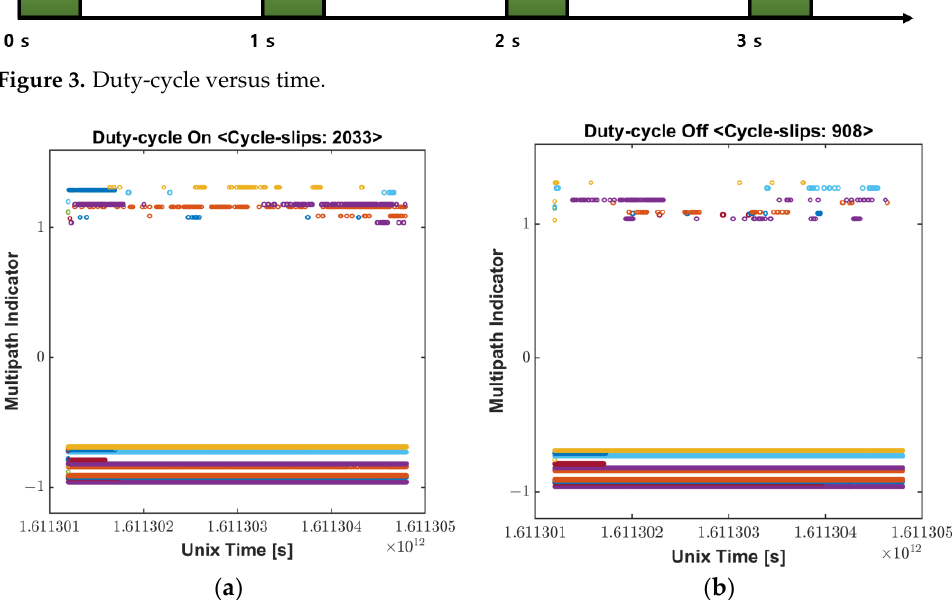
Figure 4. Cycle-slip Flag: ( a ) Duty-cycle On; ( b ) Dufy-cycle